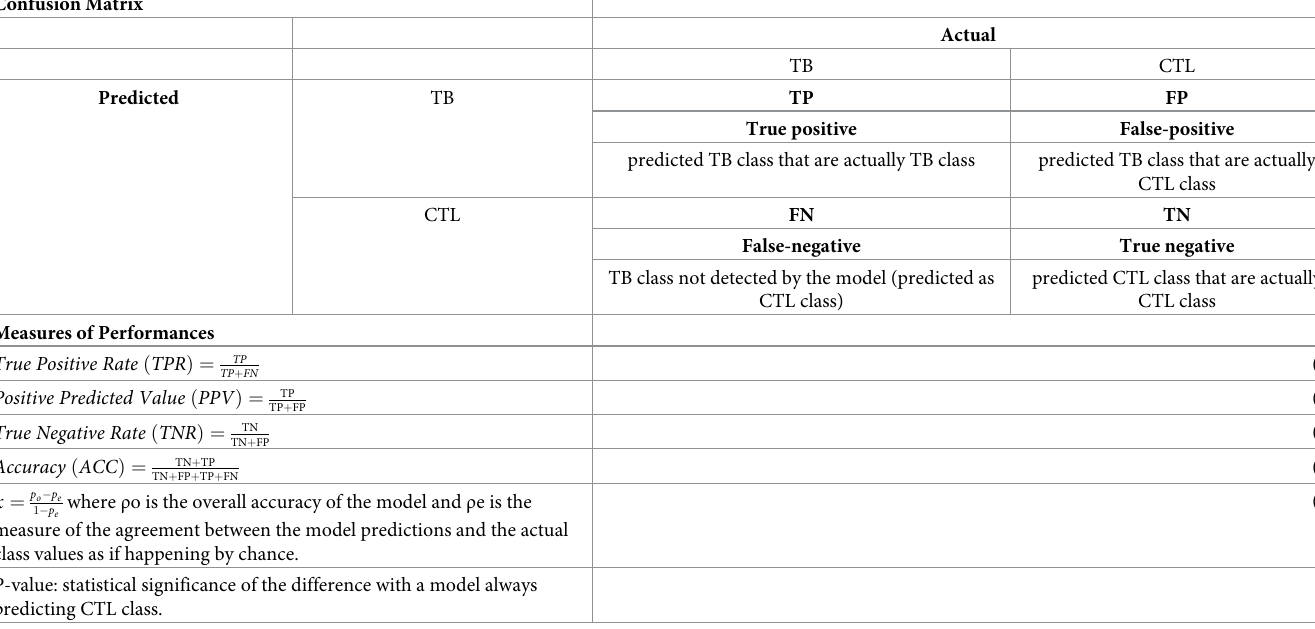
Table 4. The confusion matrix and measures of performances used to assess the performances of the models. Confusion